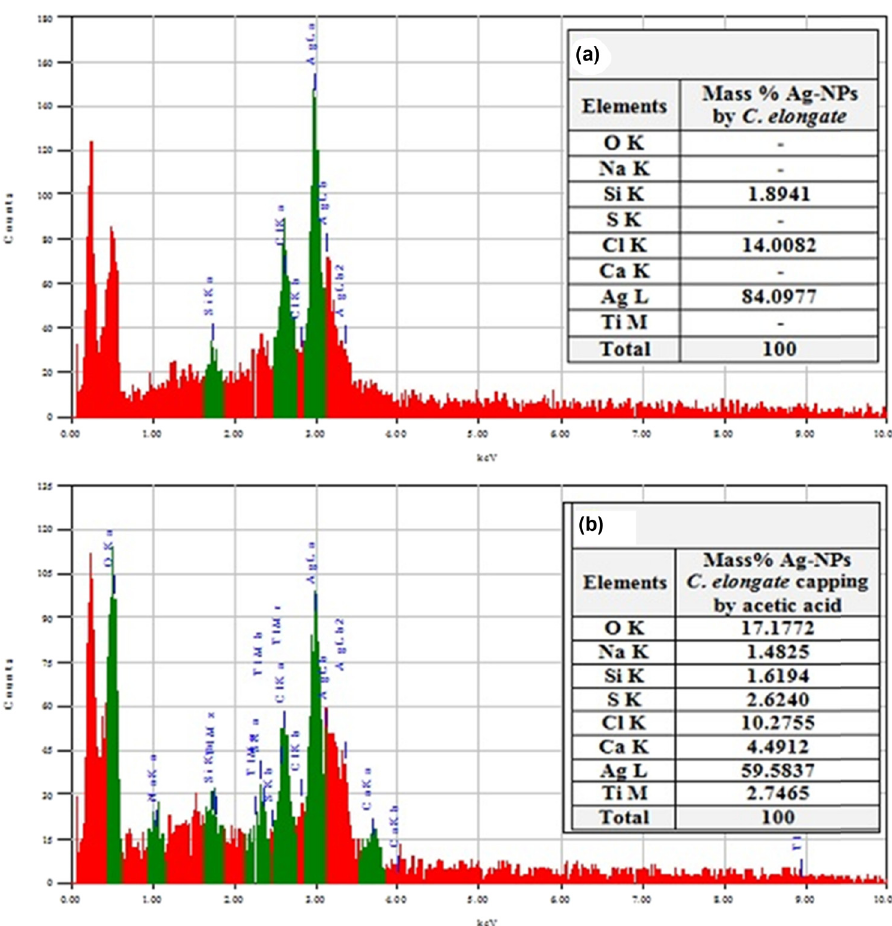
Figure 3: EDX spectrophotometry analyses of bio - fabricated AgNPs by C. elongata ( a ) and capping bio - synthesis AgNPs by acetic acid ( b ) with the di ff erent percentages mass of